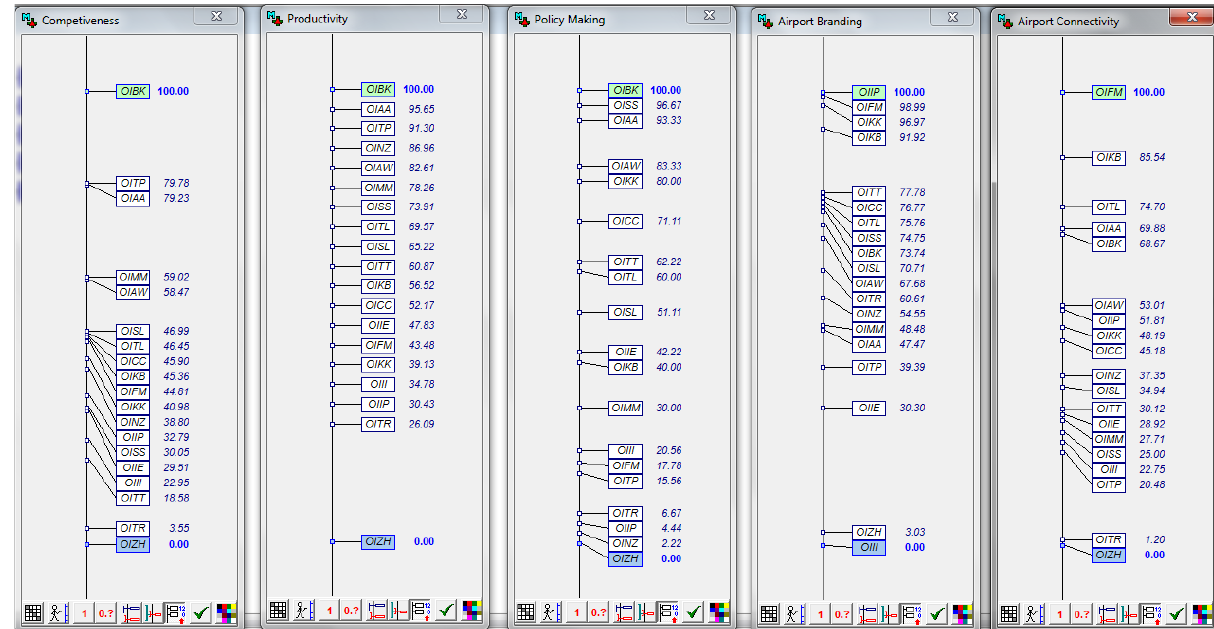
criterionFigure Figure 4. Table of alternatives’ ranking according to each